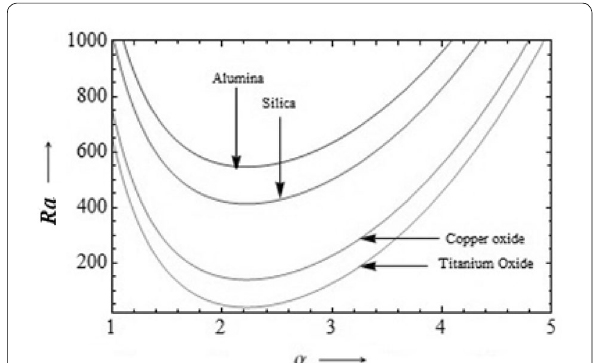
Fig. 3 Effect of non-metals on Rayleigh number [67]